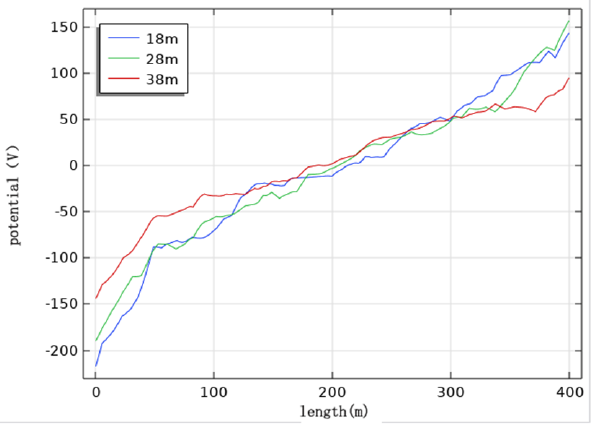
Figure 20. The influence of the law of transmission line height on cathodic protection potential.